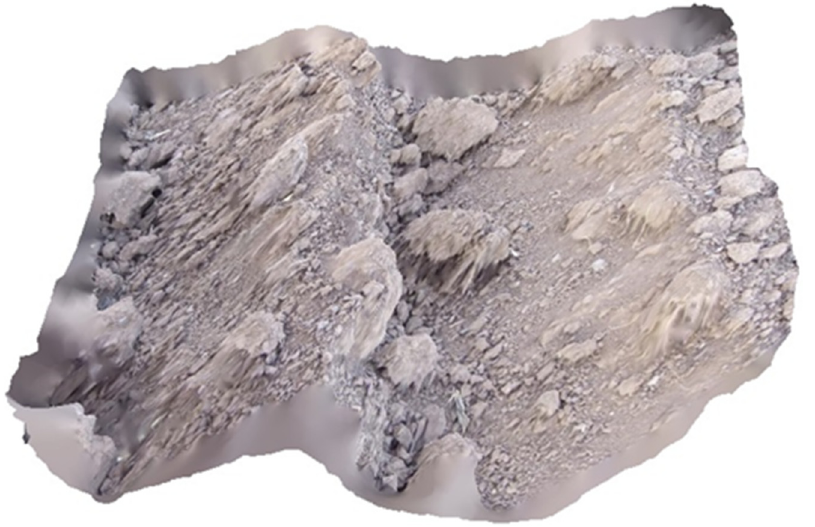
Figure 6. A sample of the 3D model obtained from the stereo image of soil surface of a tilled soil by the disk implement.